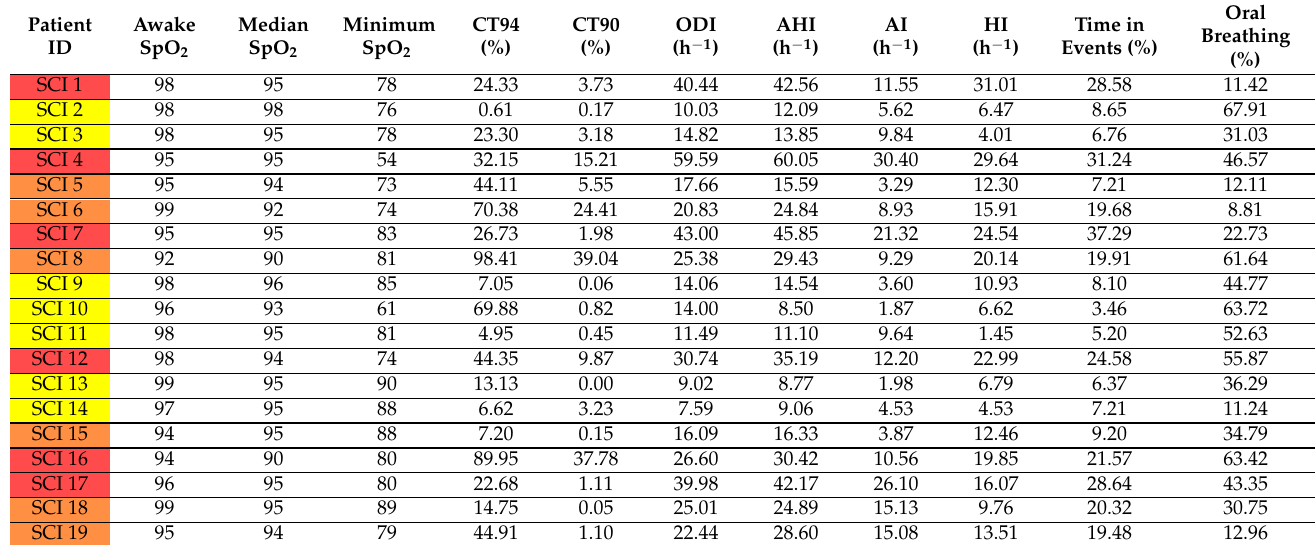
Table 2. Outcome measures for all SCI patients. Patients with mild sleep apnea (5 ≤ AHI < 15) are highlighted in yellow, patients with moderate sleep apnea (15 ≤ AHI < 30) in orange, and patients with severe sleep apnea (AHI ≥ 30) in red.